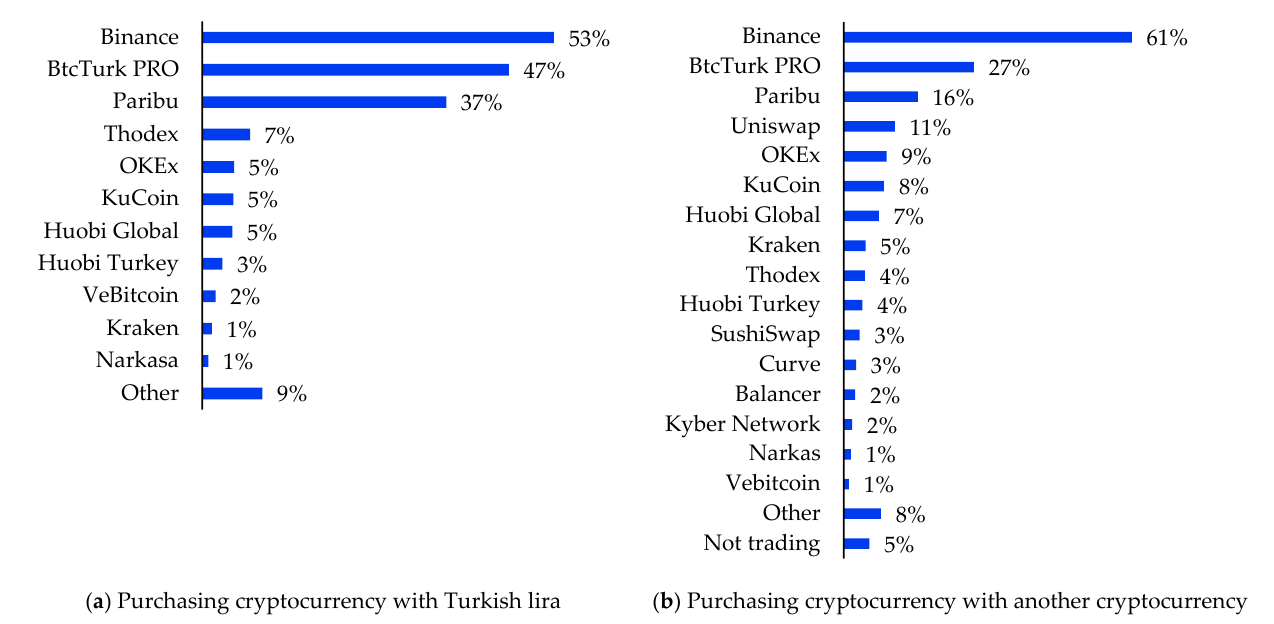
Figure 2. Selected descriptive statistics of cryptocurrency purchases across different cryptocurrency exchanges: ( a ) cryptocurrency exchanges used to purchase cryptocurrency with Turkish lira; ( b ) cryptocurrency exchanges used to purchase cryptocurrency with another cryptocurrency. N = 715 Turkish cryptocurrency owners.